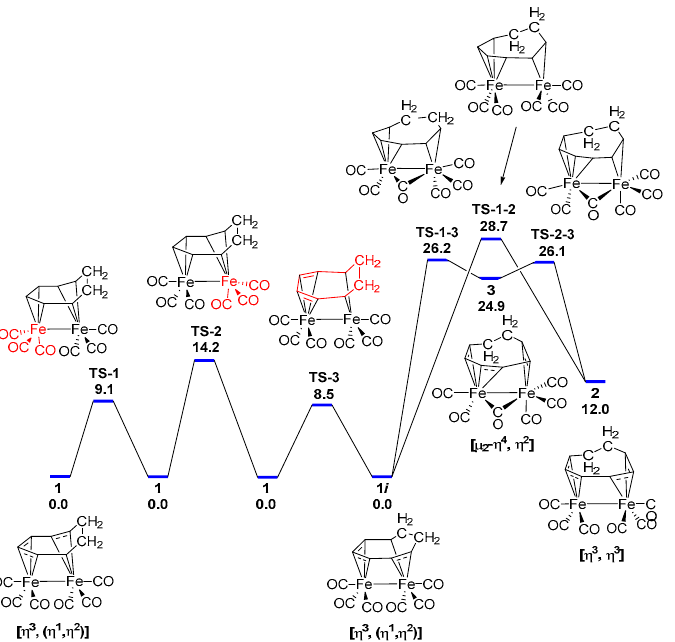
Figure 3. Free energy diagram of (C 8 H 10 )Fe 2 (CO) 6 . All Gibbs energies are relative to complex 1.